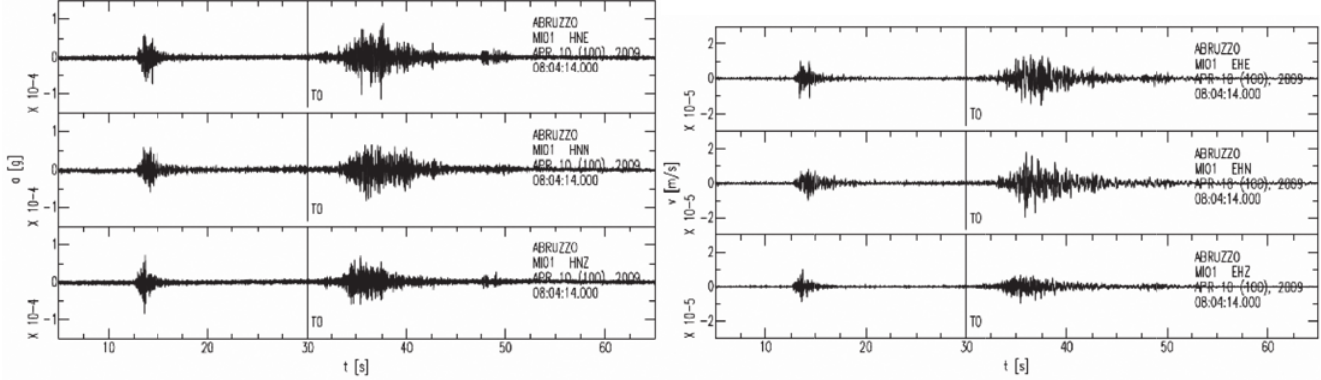
Figure 8. Waveforms of a ML = 1.5 earthquake recorded at station MI01 by a six-component acquisition system equipped with both strong-motion (left panel) and weak-motion (right panel) sensors. At least two of these events overlap between 30 s and 40 s, and a small event occurred before the selected earthquake was detected (between 10 s and 20 s).